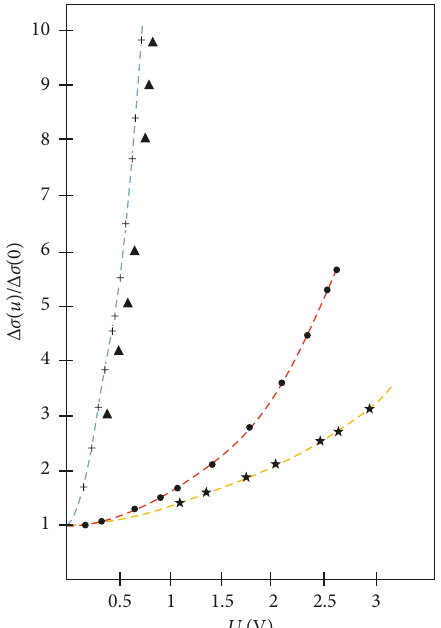
Figure 9: Dependence of Δ σ ( U ) / Δ σ ( 0 ) on the electric field U at the line at T � 4 . 2K is shown for (1) H � 36 . 5 kOe top of 1s ⟶ 2p + 1 by + -points; for (2) H � 61 . 8kOe by ▲ -points when ε ‖ H and for (3) 36 . 5 kOe by • -points; for (4) H � 61 . 8 kOe by ∗ -points when ε ⊥ H in the same